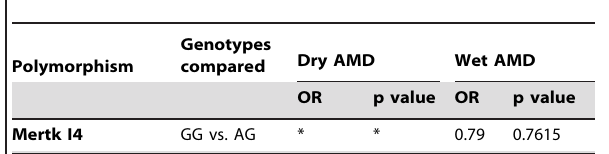
Table 2. Unadjusted ORs of the examined